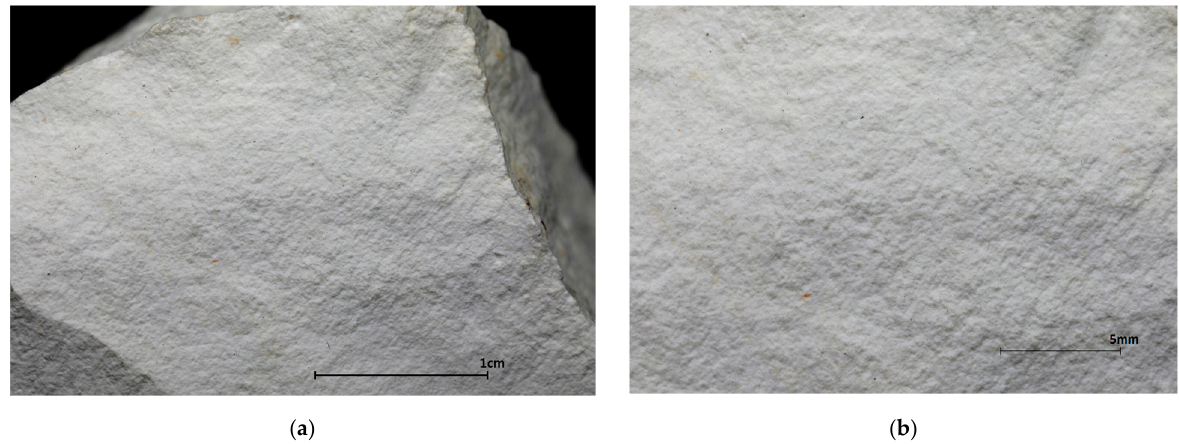
Figure 3. Representative image of the white bentonite sample from Ora ș u Nou used in the determinations. ( a ) Bentonite fragment; ( b ) Detail in the bentonite sample.